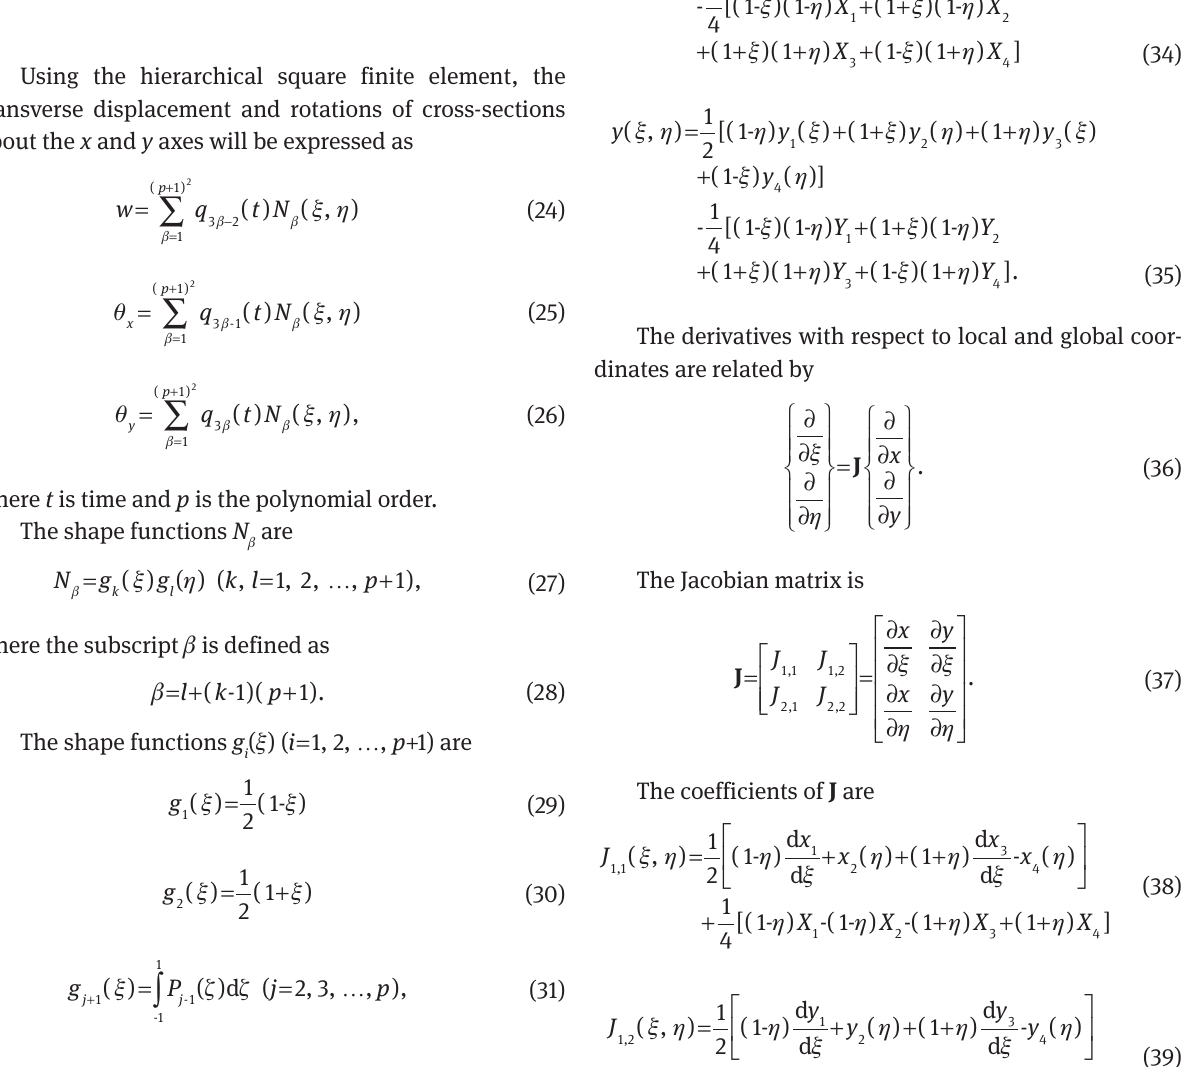
Figure 3: The curved hierarchical square finite